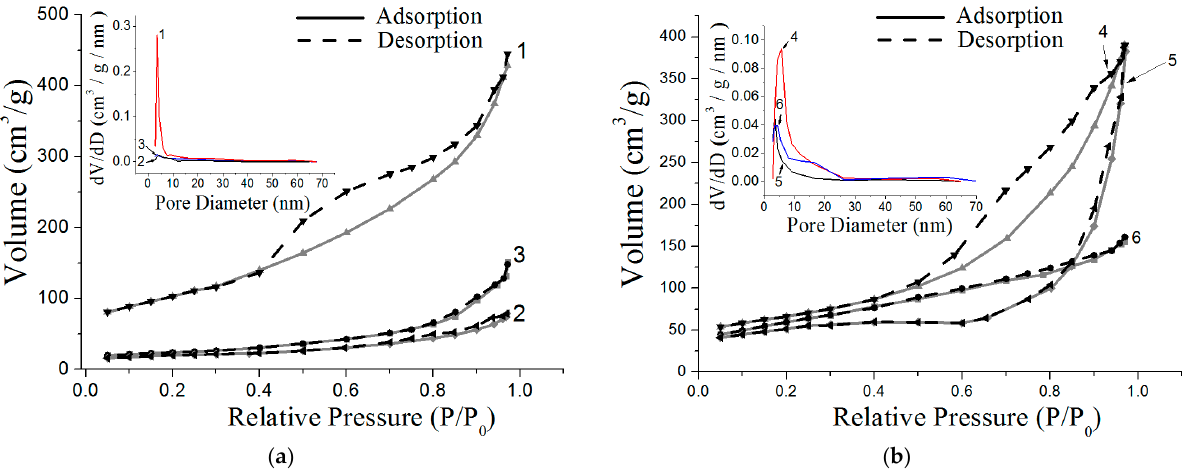
Figure 13. Nitrogen adsorption–desorption isotherms before ( a ) and after ( b ) thermal treatment of nanoscale structures and pore size distribution (inset) for samples 1–6.